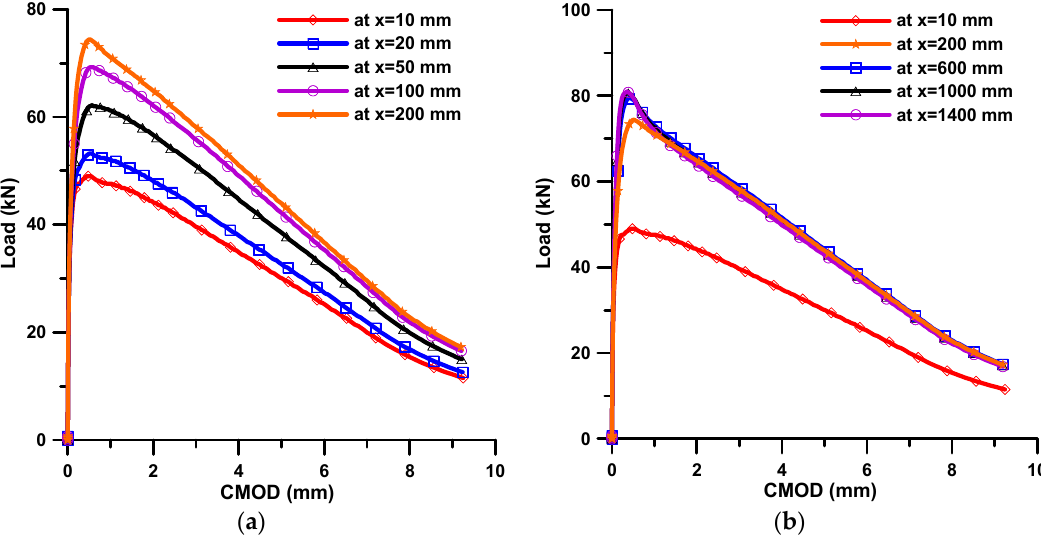
Figure 10. Load-CMOD curves obtained from FEM analysis; ( a ) up to 200 mm flow distance; and ( b ) for overall flow distance.